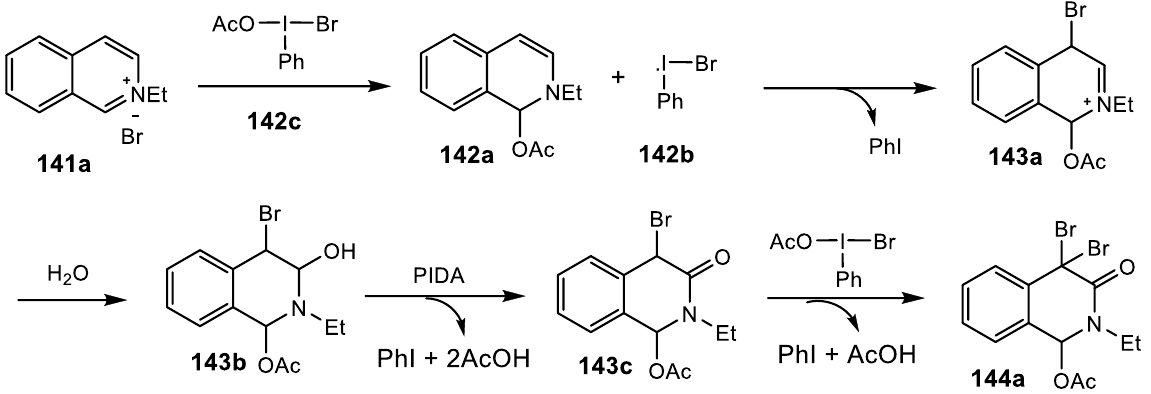
Figure 20. Possible mechanism for the PIDA-mediated oxidation.